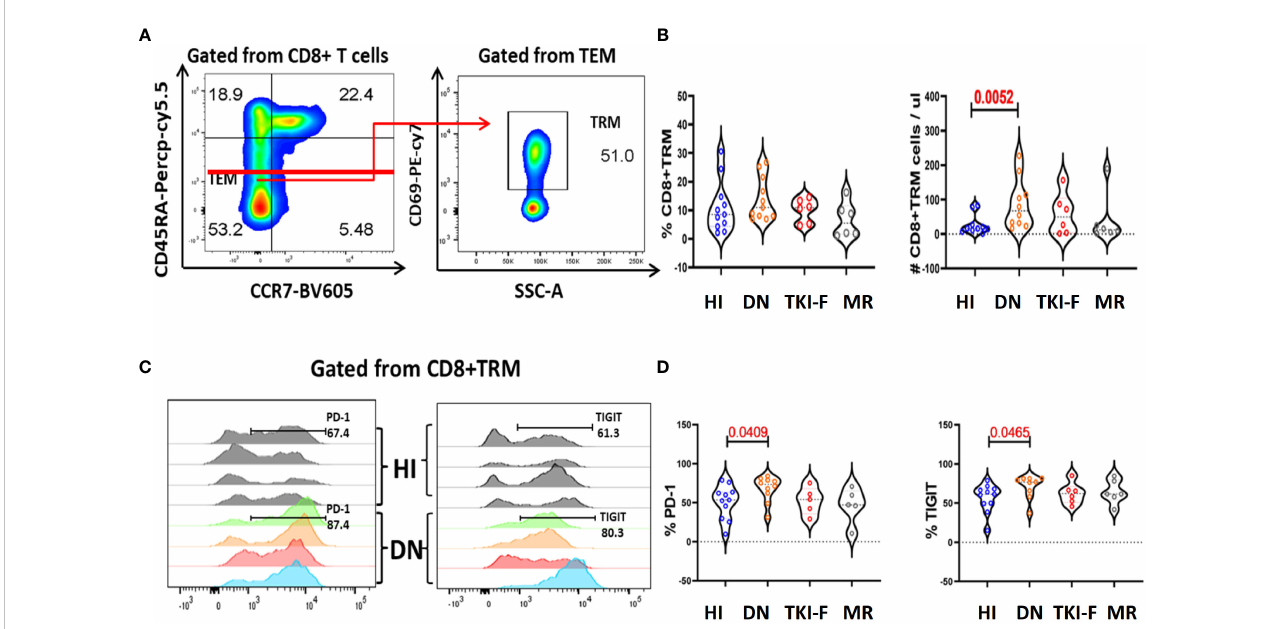
FIGURE 3 The absolute numbers of CD8 + T RM cells increased in the BM of DN-CML patients while accompanied by an elevated expression of PD-1 and TIGIT. (A) Gating strategies to indicate the T RM cells. CD45RA - and CCR7 - were used to identify the T EM subsets and then T RM cells were further gated by CD69 expression. (B) The percentage and absolute number of CD8 + T RM cells in HIs, DN-CML, TKI-F, and MR patients. (C) Flow-cytometry analysis detected the frequency of PD-1 + CD8 + T RM (left) and TIGIT + CD8 + T RM (right) in HIs (top: n = 4) and DN-CML (below: n = 4). (D) Increased proportion of PD-1 (left) and TIGIT (right) on CD8 + T RM cells in BM from HIs (n = 10) and DN-CML (n = 10), TKI-F (n = 6), and MR (n = 6) patients. The P values shown are from the Mann-Whitney U test between